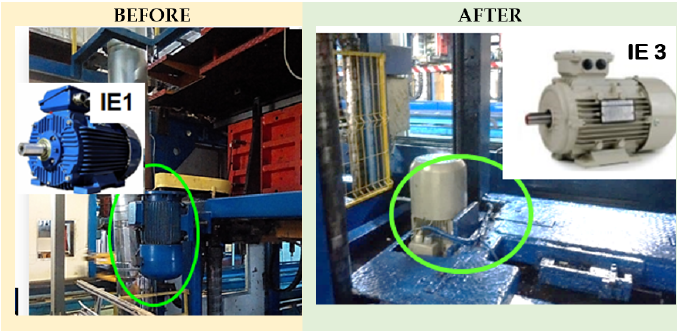
Figure 11. Engine positioning before and after applying the Kaizen